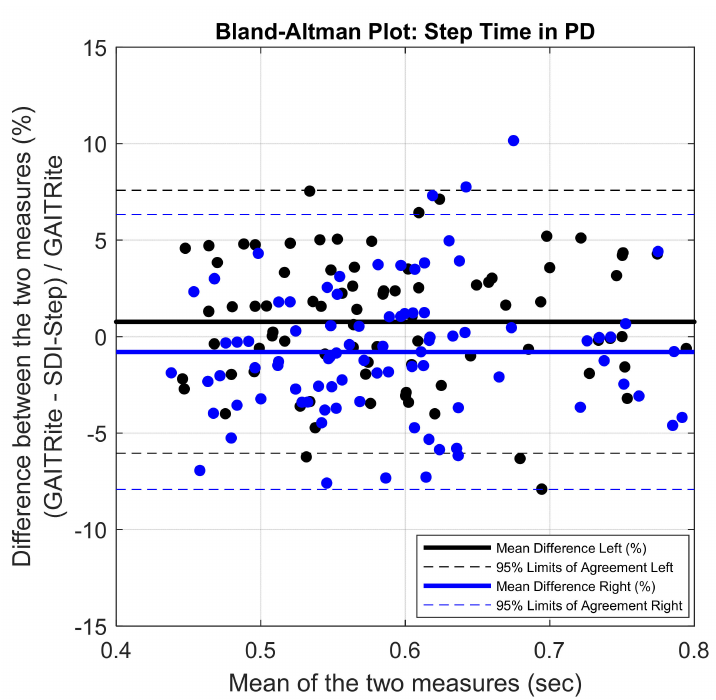
Figure 5. Bland–Altman plots demonstrating agreement between GAITRite and IMU SDI-Step Algorithm for right (blue) and left (black) step time in PD. Solid line represents the mean di ff erence in step time values between the two measures in percentage. Table 1. The step length and step time gait measures calculated using SDI-Step are compared to measurements from the lab-based reference system (GAITRite for YA 1 and PD participants and Motion capture system for YA 2 participants). The degree of agreement between our algorithm and the reference systems calculated using various agreement methods are also provided. The BA-bias was collected by subtracting the value calculated using the SDI-Step algorithm from the value obtained from the reference system. The units of mean, SD, PB Intercept with CI, and BA-bias with LoA for step length and step time are in meters and seconds, respectively. SDI-Step: Segmented